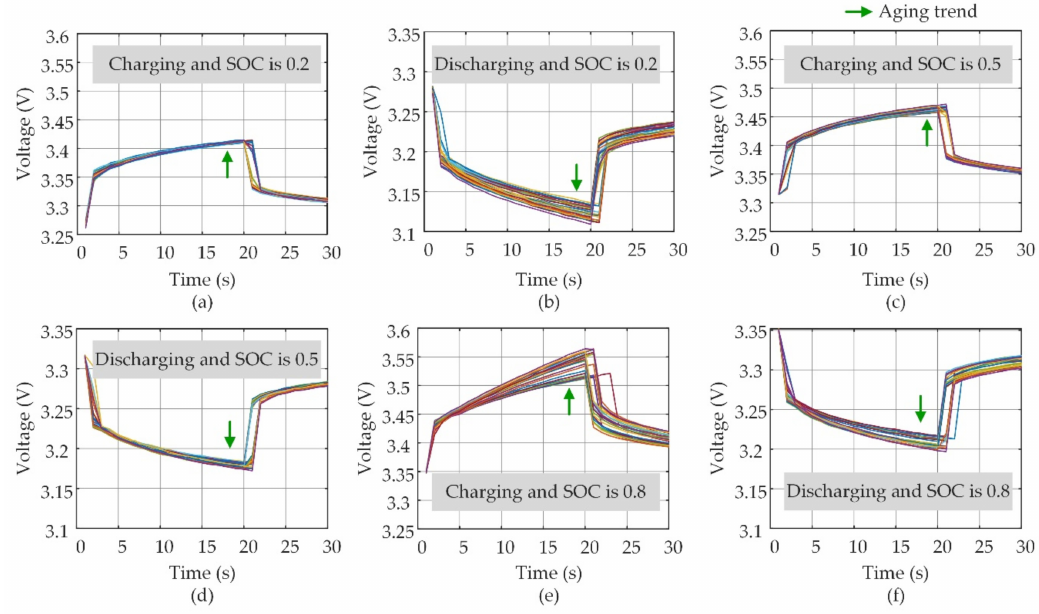
Figure 7. Voltage datasets under di ff erent test conditions (TCs) during the battery aging process.